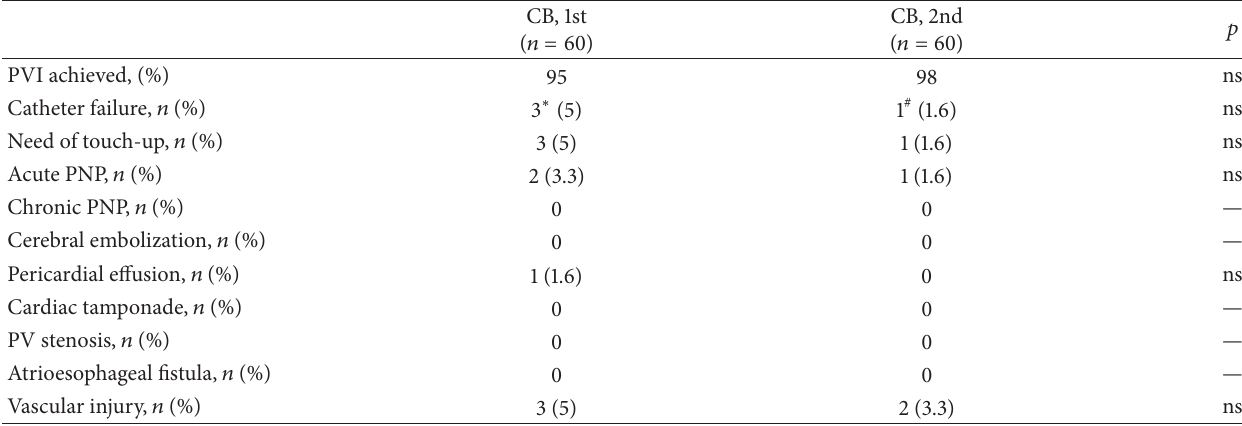
Table 3: Acute success and procedure-related complications.